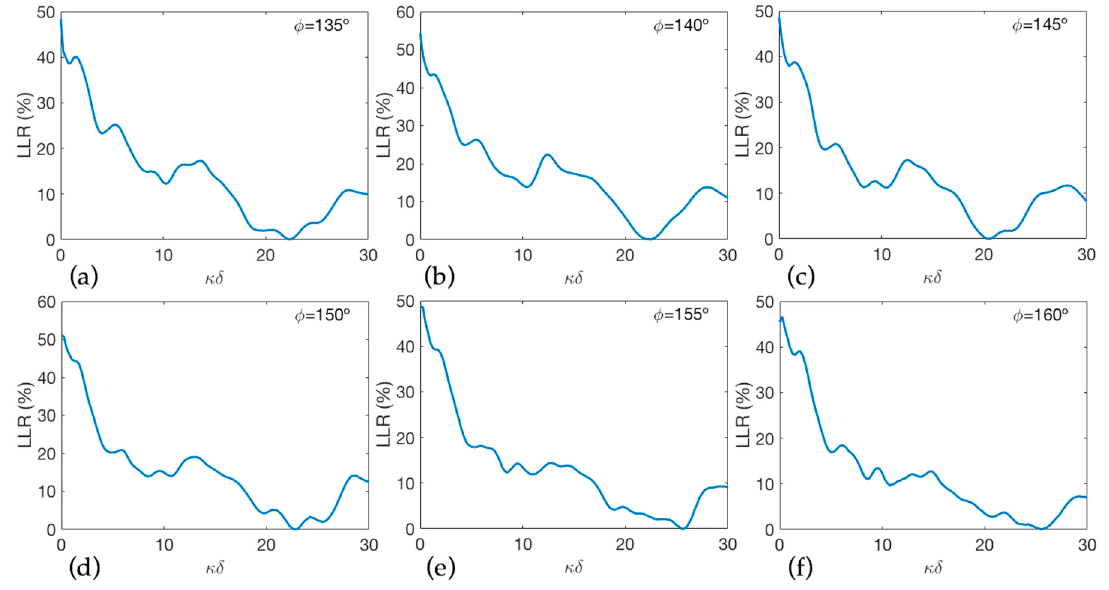
Figure A2. The relative percentage loss of lateral resolution (LLR) as a function of κδ . ( a ) F/N = 0.092; ( b ) F/N = 0.13; ( c ) F/N = 0.16; ( d ) F/N = 0.21; ( e ) F/N = 0.28; ( f ) F/N = 0.33.